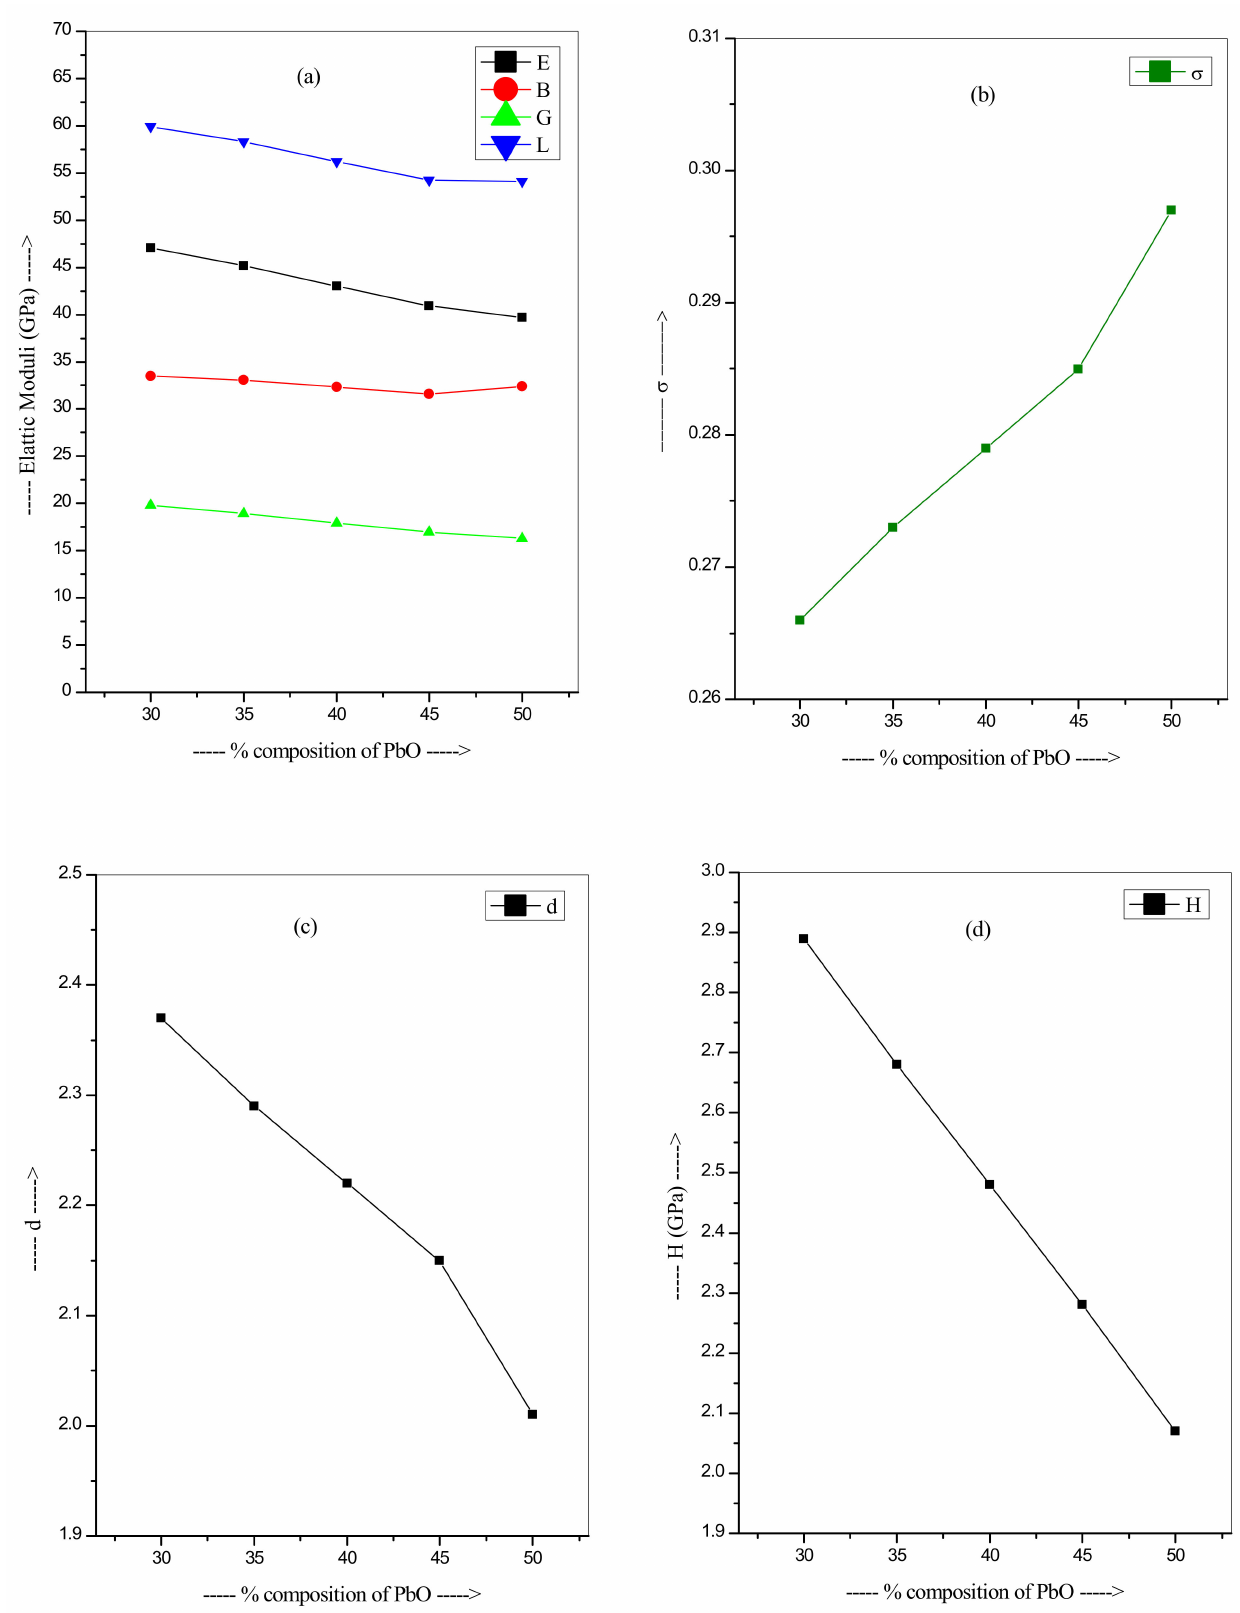
Figure 2. Variation of mechanical properties ( a ) elastic moduli ( b ) σ ( c ) d ( d ) H with PbO